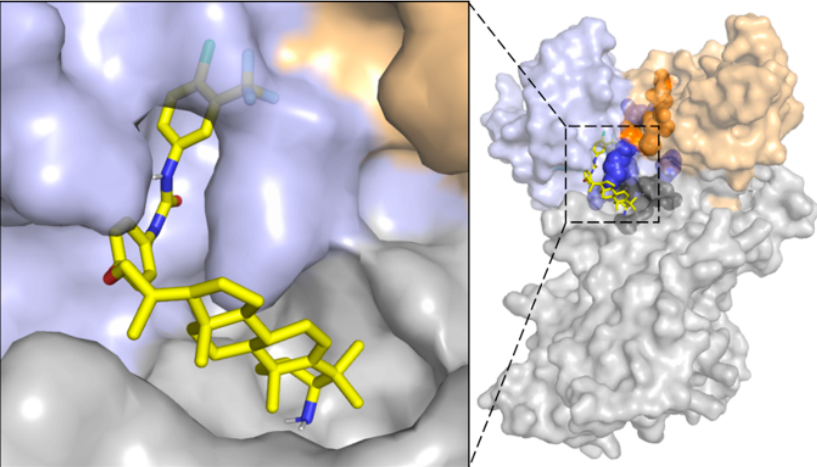
Figure 2. Proposed binding mode of 5ba and SHP1 in open conformation. Reported residues on the interfaces to stabilize active SHP1 are shown as spheres. Compound is shown in yellow. N-SH2, C-SH2, and PTP domains are shown in blue, orange, and gray, respectively.